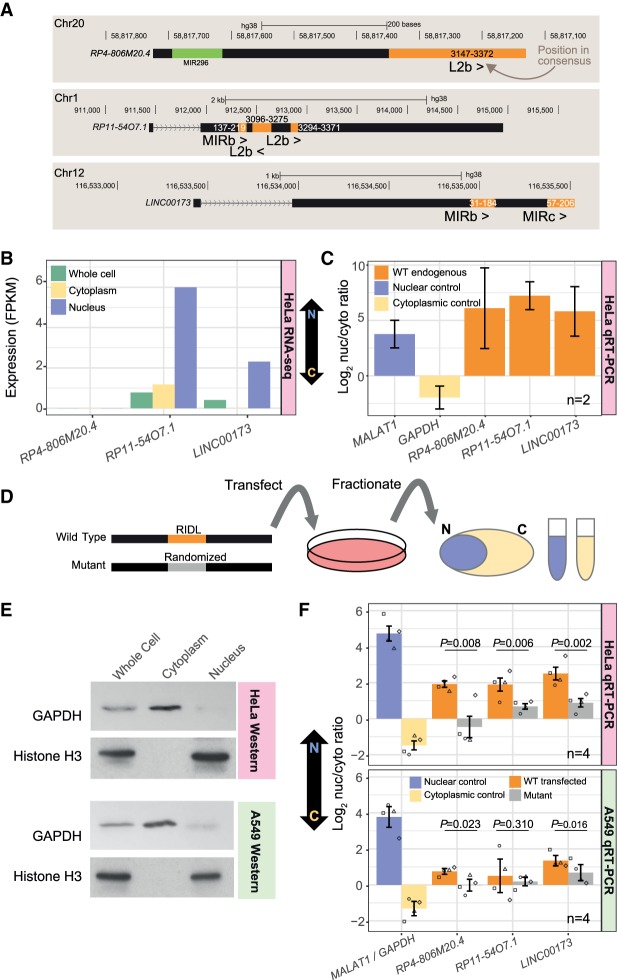
Disruption of RIDLs results in lncRNA relocalization from nucleus to cytoplasm. (A) Structures of candidate RIDL-lncRNAs. Orange indicates RIDL positions. For each RIDL, numbers indicate the position within the TE consensus, and its orientation with respect to the lncRNA is indicated by arrows. (>) same strand; (<) opposite strand. (B) Expression of the three lncRNA candidates as inferred from HeLa RNA-seq (Djebali et al. 2012). (C) Nuclear/cytoplasmic localization of endogenous candidate lncRNA copies in wild-type HeLa cells as measured by qRT-PCR. (D) Experimental design. (E) The purity of HeLa and A549 subcellular fractions was assessed by western blotting against specific markers. GAPDH/Histone H3 proteins are used as cytoplasmic/nuclear markers, respectively. (F) Nuclear/cytoplasmic localization of transfected candidate lncRNAs in HeLa (top) and A549 (bottom). GAPDH/MALAT1 are used as cytoplasmic/nuclear controls, respectively. (N) Number of biological replicates (values from all replicates are plotted; each replicate is represented by a different dot shape). Error bars, SEM. P-values for paired t-test (one tail) are shown.